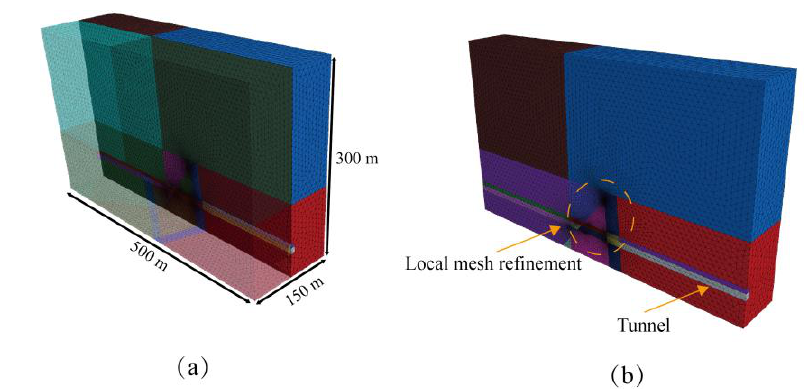
Figure 9. Relationship between magnitude and frequency of microseismic events (20 October 2020